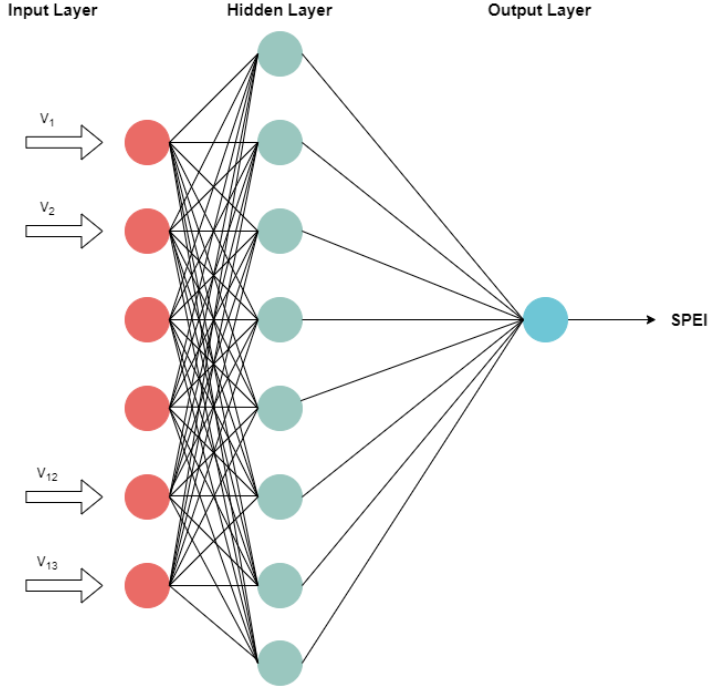
Figure 3. General architecture of an artificial neural network (ANN) model.